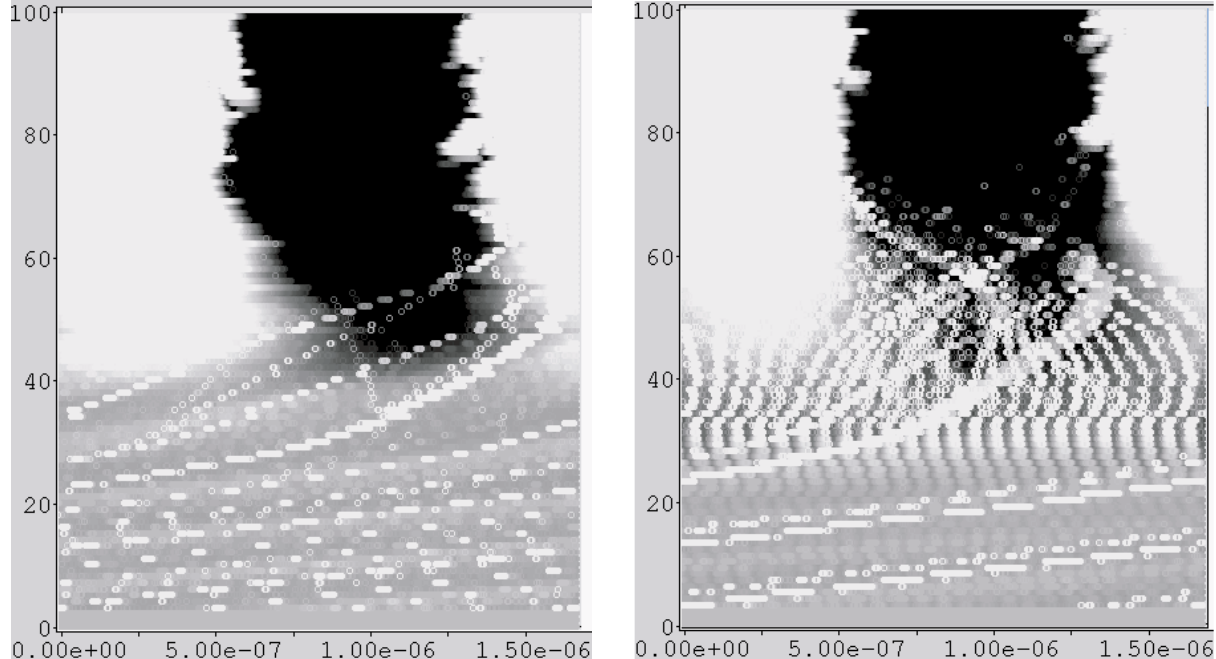
FIG. 7. Waterfall plots of rf capture with (right) and without (left) high-harmonic bucket deposition. 3.2 3 10 12 protons, one trace each 20 turns, vertical span 3.3